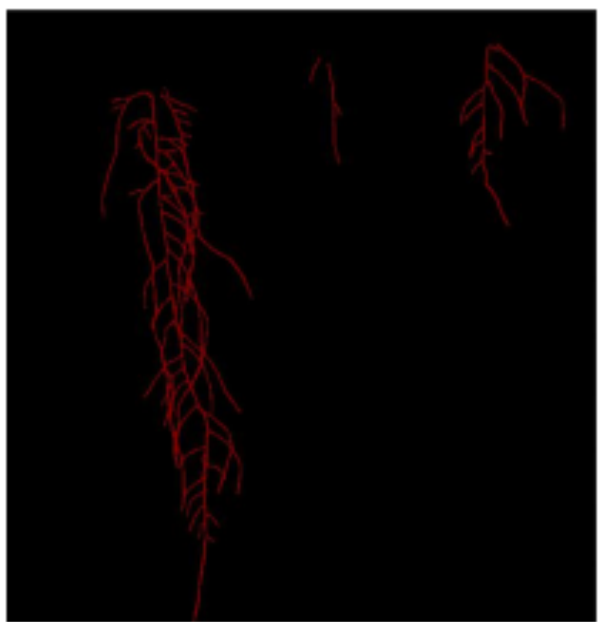
Figure 8. Example of the corresponding annotation from Figure 7. The annotations are clear and include the same generated root architecture present in Figure 7.